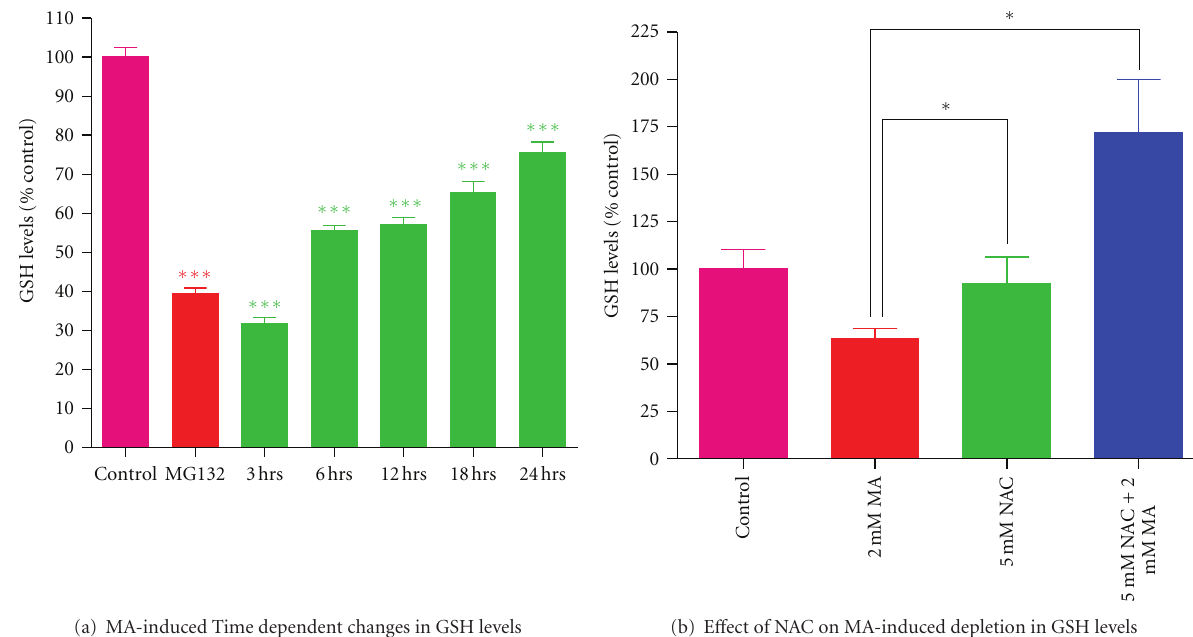
Figure 2: E ff ect of NAC on MA-induced reduction in total GSH levels. (a) Determination of cellular GSH. N27 dopaminergic cells were treated with 2mM MA for 3, 6, 12, 18, and 24 hours. MA-induced reduction in GSH levels was measured by the monochlorobimane fluorometric method. The data represent mean ± SEM of six individual measurements. Asterisks ( ∗∗∗ P < 0 . 001) indicate significant di ff erences between MA-treated cells and untreated control cells. Values are expressed as percentage of GSH compared with untreated control. Treatment of N27 dopaminergic cells with 5 μ M MG132 is considered as positive control. (b) Determination of cellular GSH levels in N27 dopaminergic cells preincubated (1 hour) with 5 mM NAC prior to MA treatment for 18 hours. The data represent mean ± SEM of four individual measurements. Asterisks ( ∗ P < 0 . 05) indicate significant di ff erences between MA- treated cells and NAC alone or NAC with MA-treated cells. Values are expressed as percentage of GSH compared with untreated